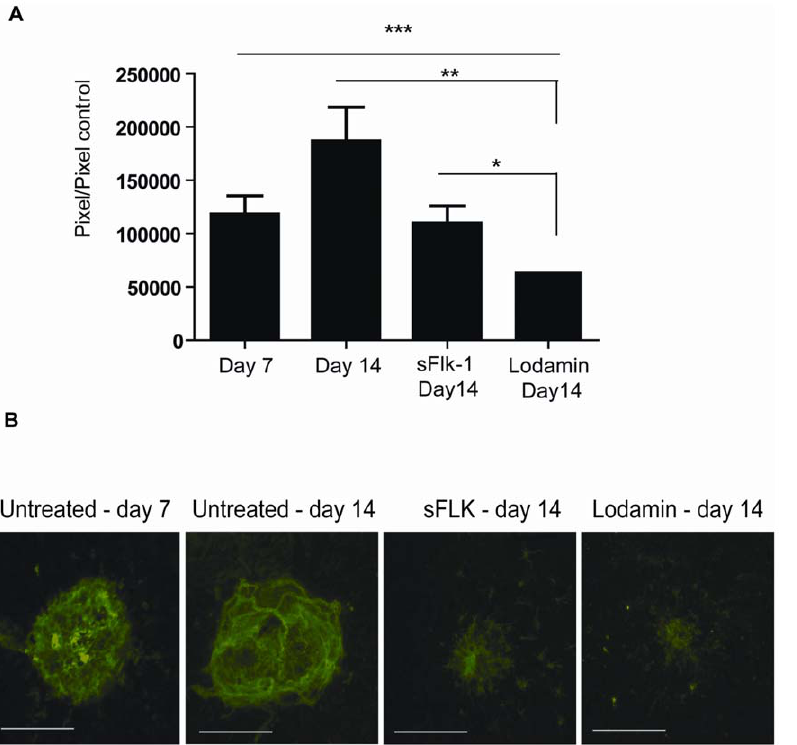
Figure 5. Comparison of the effect of Lodamin or sFlk-1 on choroidal vessel regression. For CNV regression studies intravitreal injections of Lodamin or sFlk-1, a recombinant mouse VEGF R2/KDR Flk-1 Fc Chimera, were performed on established CNV lesions at day 7 post laser induction. After 14 days of laser induction (7 days post intravitreal injection of Lodamin or sFlk-1) fluorescent images of choroidal flat-mounts were captured and CNV area (presented in m m 2 ) in choroidal flat mount was evaluated using Scion image software. ( A ) CNV size data of untreated mice bearing laser induced CNV at day 7 and 14, compared to Lodamin or sFlk-1 treated mice 7 days after their injection. Data is presented as mean pixel number 6 SEM (n=15–27 spots, *P , 0.05,